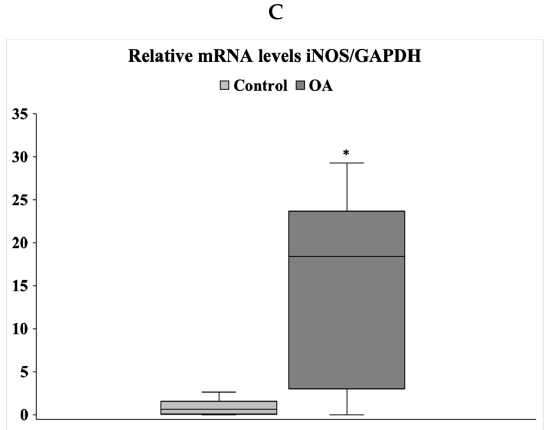
Figure 4. The osteoarthritic chondrocytes had elevated levels of oxidative stress even before the exposure to exogenous oxidative insult. ( A ) Characteristic images of control and OA chondrocytes (from three control and three OA patients samples, see method described in Materials and Methods) where total ROS and superoxide levels were analysed under normal conditions (Control-OA) and after pyocyanine was added to the control cells in order to serve as the positive control (Control + PYO). Images were captured with the 40× objective lens of the fluorescent microscope used. Scale bar 25 µ m. ( Bi ) Oxidative DNA lesions were assessed by staining with 8-oxo-dG antibody and the appropriate secondary antibody (green). Nuclei bearing >5 foci stained with 8-oxo-dG were counted as positive. Nuclei were stained with DAPI (blue). Images were captured with the 40× objective lens of the fluorescent microscope used. Arrows point at nuclei having characteristic green foci indicative of the formation of 8-oxo-dG. Scale bar 25 μ m. ( Bii ) Percentages of chondrocytes’ nuclei bearing 8-oxo-dG lesions from three control and three OA patients samples (Control-OA). Values shown are the means ± S.E. ** p < 0.01 versus control cells. p values were calculated using the Student t -test. ( C ) Box blot demonstrating the quantification of relative mRNA levels of iNOS in the control and OA chondrocytes. The horizontal lines inside the boxes denote the medians and the horizontal borders of the boxes the interval between the 25th and 75th percentiles. The whiskers show the minimal and maximal values. Analysis was performed using chondrocytes from four healthy donors and four OA patients. * p < 0.05 versus control. p values were calculated using the Mann–Whitney U test.